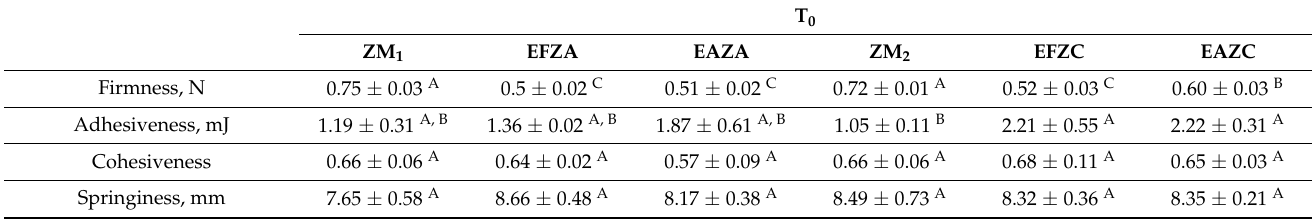
The averages on the same lines with different superscripts (A, B, and C) are statistically significantly different ( p < 0.05). ZM 1 and ZM 2 are zucchini purees treated by steam convection and hot air convection,